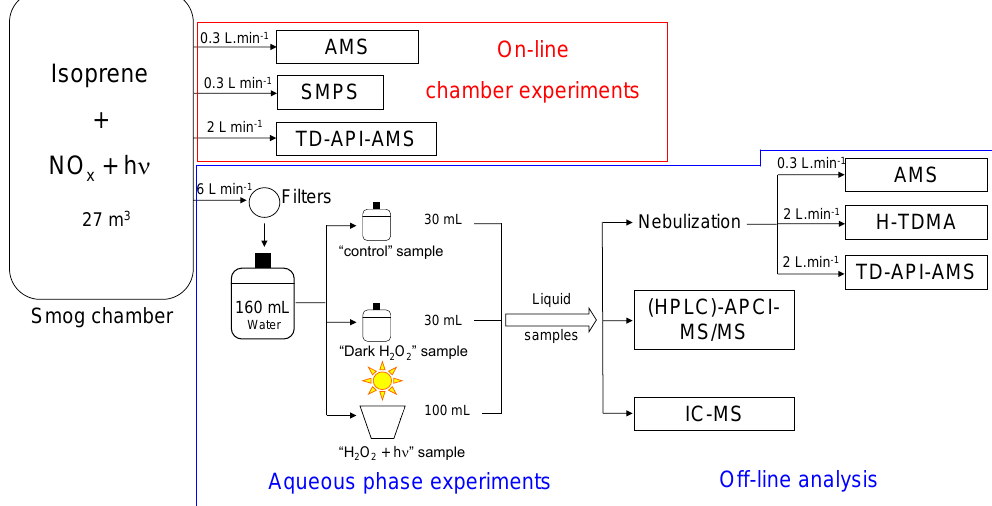
Fig. 1. General scheme of the experiments, including SOA formation in the smog chamber, particles sampling (on filters) and subsequent extraction in pure water, aqueous phase processing, and nebulization, together with the analytical instruments used to characterize the physical and chemical properties of the particles.